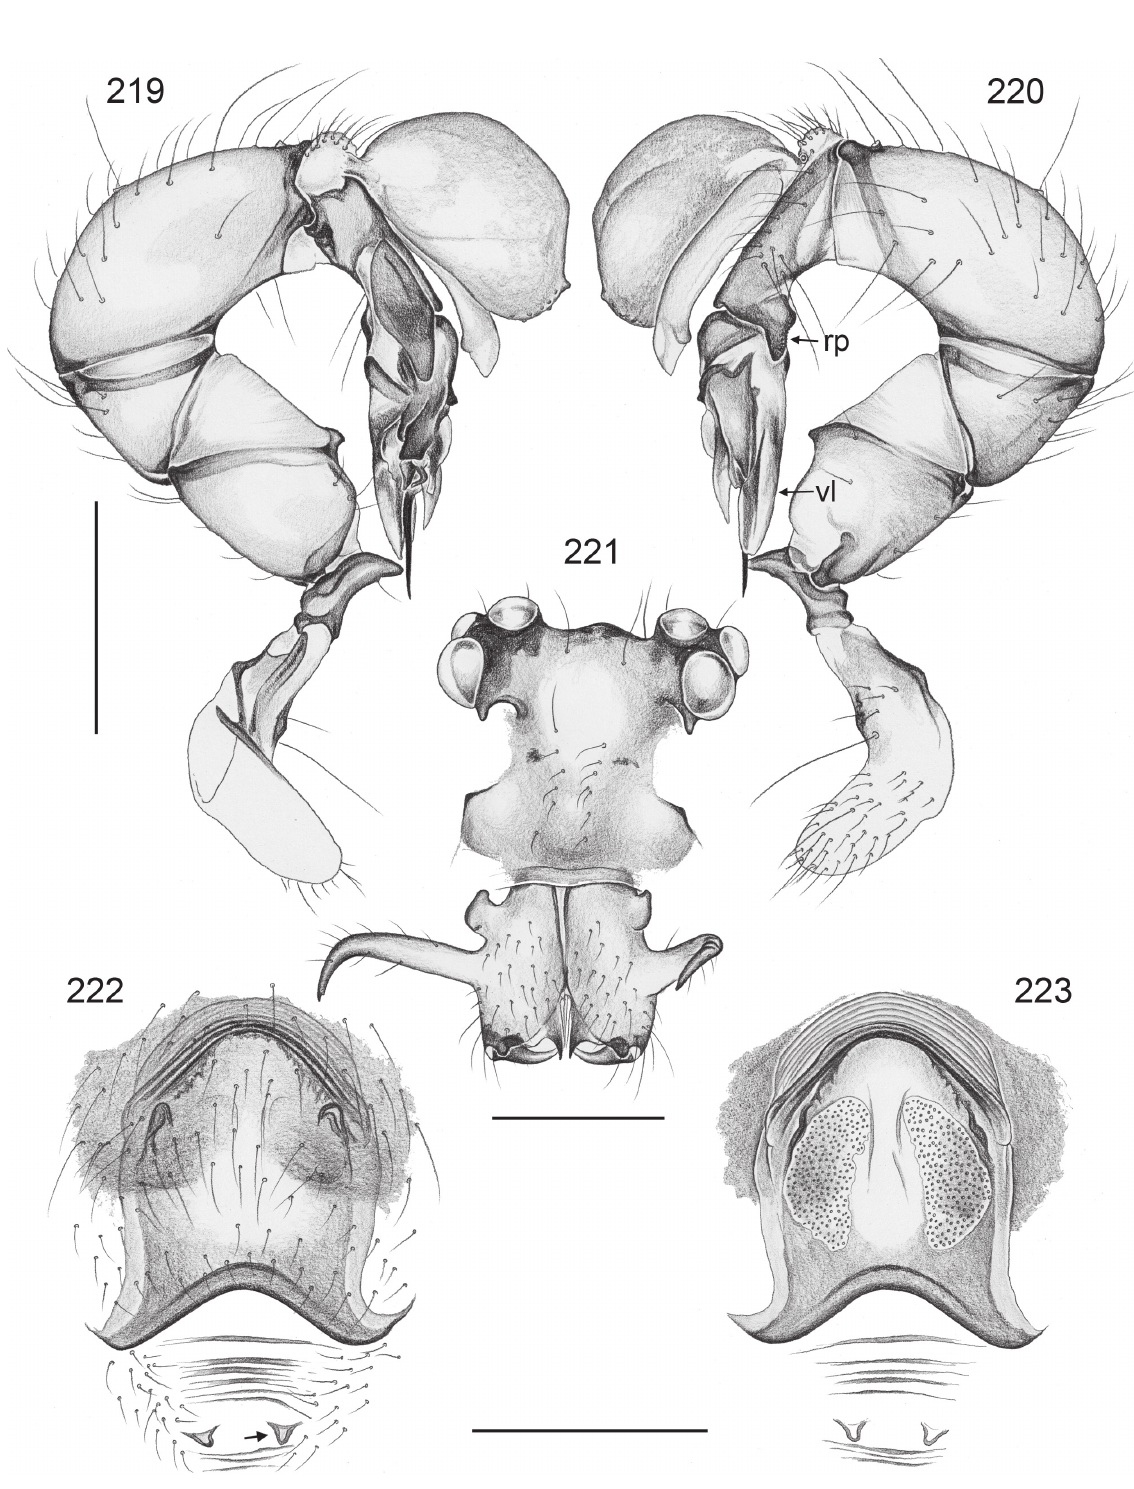
Figs 219–223. Aetana manansalai Huber, sp. nov. 219–220 . Left male palp, prolateral and retrolateral views. 221 . Male prosoma, oblique frontal view. 222–223 . Cleared female genitalia, ventral and dorsal views. Arrow points at membranous pocket. rp = retrolatero-ventral process; vl = ventral lamina. Scale lines: 0.5